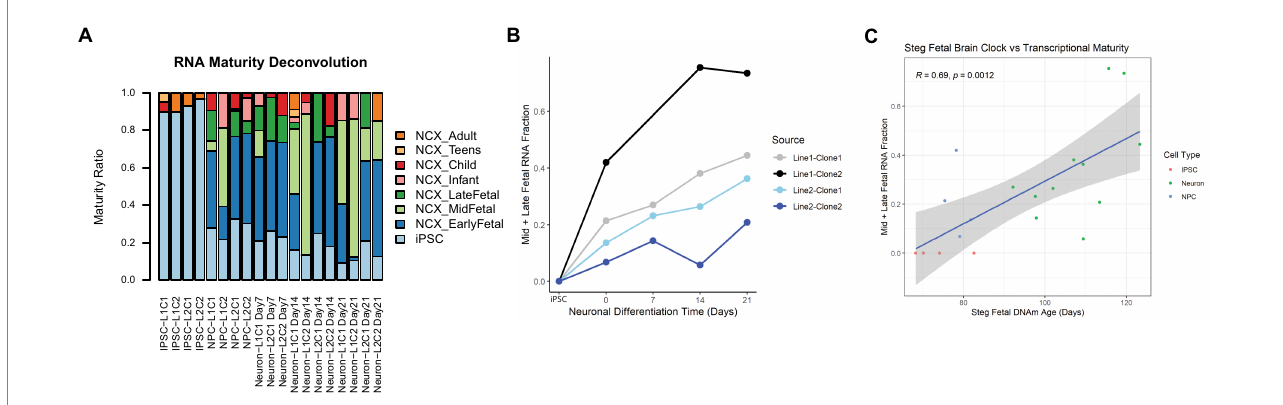
FIGURE 5 RNA transcriptional maturity across differentiation. (A) Stacked barplot showing results of RNA maturity deconvolution. (B) RNA maturity score indicated by combined Mid and Late fetal fraction plotted against neuronal differentiation time, NPCs noted as time = 0 Days, iPSCs labeled. Color of plot line indicates cell line and clone source. (C) Correlation plot between Steg Fetal Brain Clock and RNA Mid + Late Fetal transcriptional maturity, Pearson correlation coefficient and value of p labeled at top. Cell type noted by color. Linear regression line labeled surrounded by gray standard error